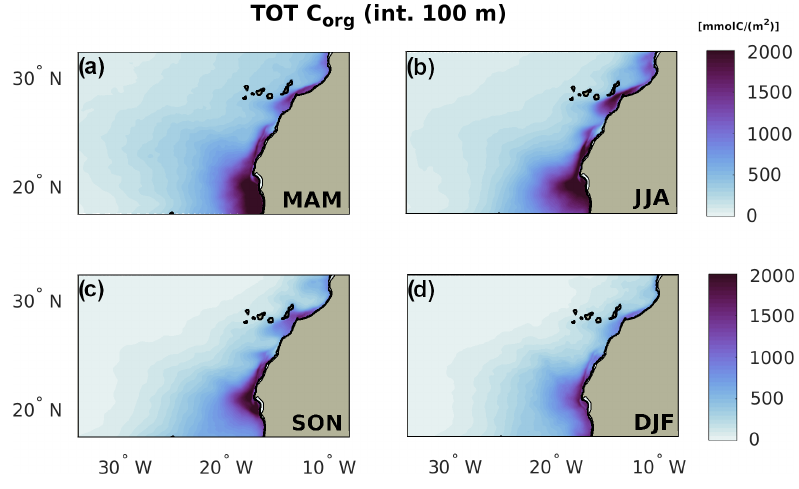
Figure B1. Total C org by season in the euphotic layer (100m depth).